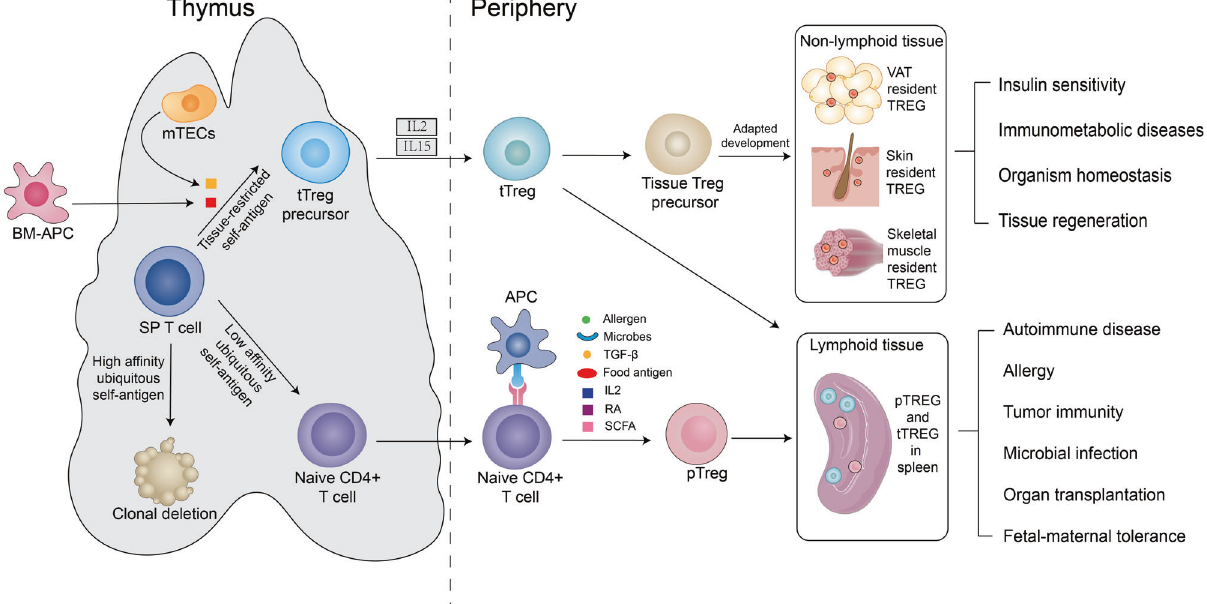
Fig. 1 The biological characteristics of Tregs. In the thymus, immature SP cells differentiate into different cell types after binding different functional af fi nity antigens (TCR signalling) with most SP cells undergoing clonal deletion. Peripheral naive CD4 + Tregs receive signals from low-af fi nity antigens and are induced by TGF- β , IL-2, RA, and other antigens to differentiate into pTregs. pTregs are mostly found in lymphoid tissues and are mainly responsible for the development of immune tolerance to exogenous antigens. SP cells initially bind to tissue-speci fi c antigens of mTECs or BM-APCs and differentiate into tTregs upon induction of IL-2 and IL-15. Some tTregs are stored in lymphatic tissues, while others are retained in non-lymphoid tissues such as fat, skin, and skeletal muscle through adaptive development where they function in tissue repair, insulin resistance, and maintenance of organismal homeostasis. mTECs, medullary thymic epithelial cells; BM-APCs, bone-marrow derived antigen-presenting cells; SP T cell, single positive T cell; Treg, regulatory T cell; tTreg, thymus-derived Treg; pTreg, peripherally derived Treg; IL-2, interleukin-2; IL-15, interleukin-15; TGF β 1, transforming growth factor beta 1; RA, retinoic acid; SCFA, short chain fatty acid; VAT, visceral adipose